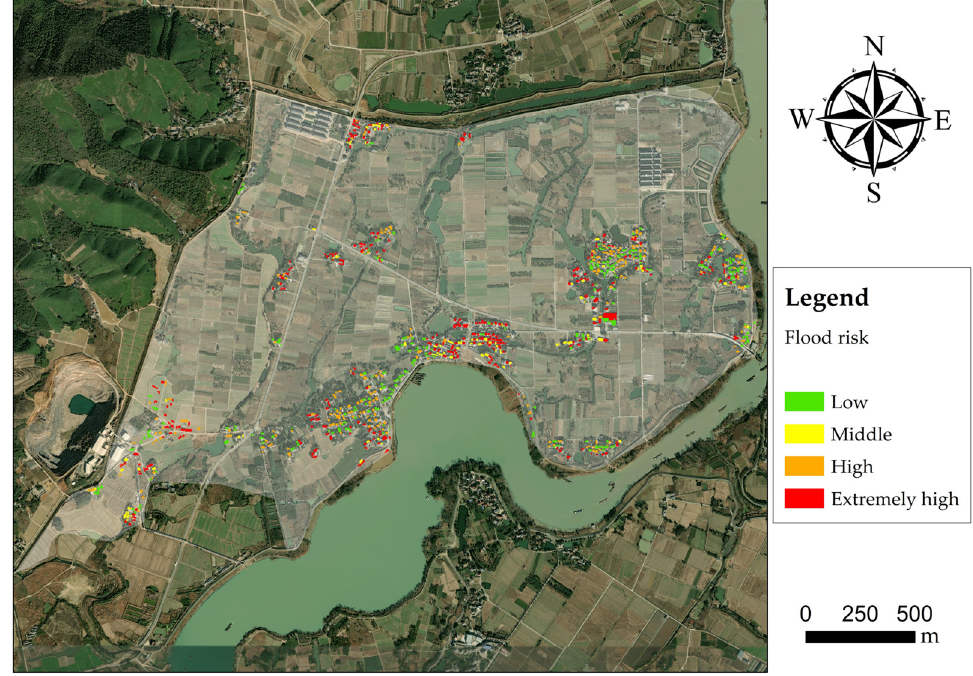
Figure 13. Flood risk assessment of buildings in flood scenario of 50-year return period.